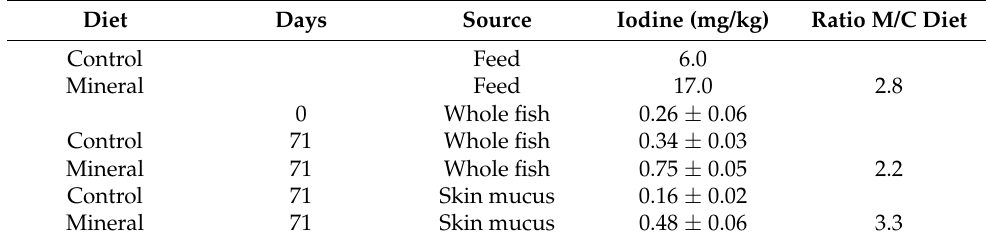
Table 2. Iodine content in the whole fish, the feeds, and skin mucus. Diet Days Source Iodine (mg/kg) Ratio M/C Diet Control Feed 6.0 Mineral Feed 17.0 Whole